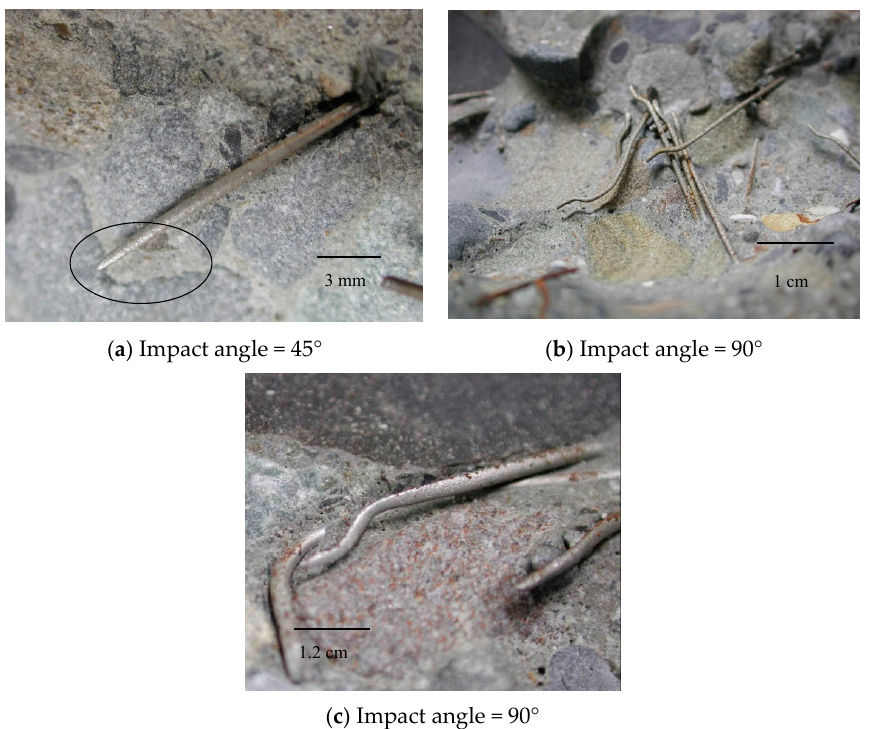
Figure 7. Typical abrasion site in steel fiber concrete abraded by impact abrasive action (w/cm = 0.36, waterborne sand flow).